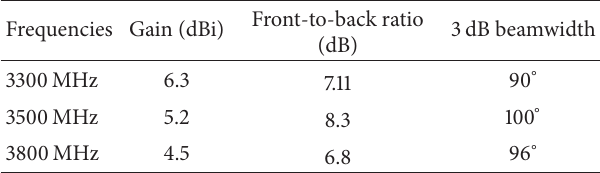
Table 6: Properties of radiation patterns of the